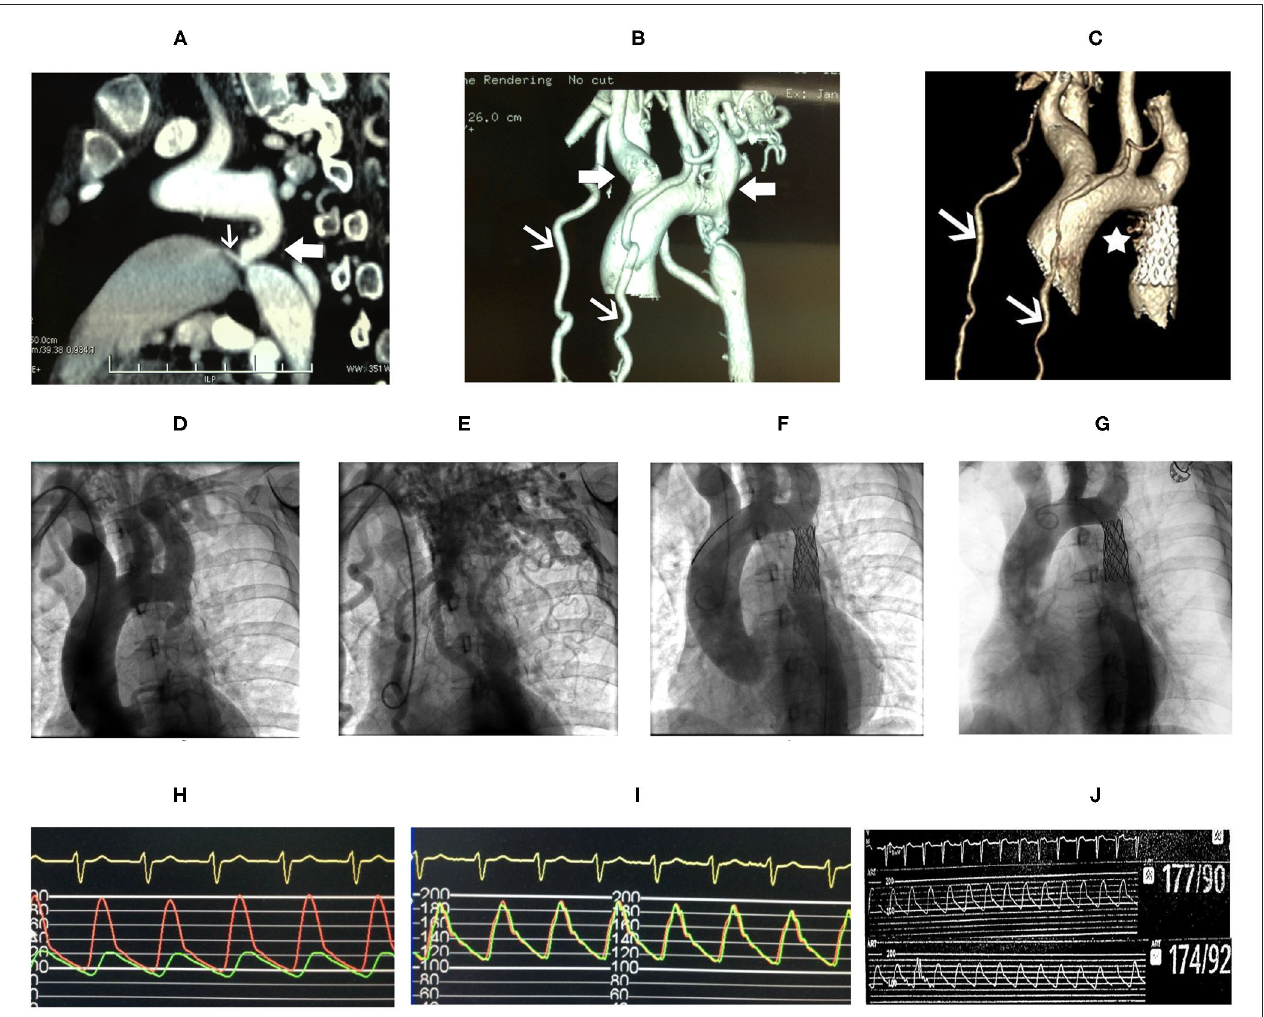
FIGURE 2 | CT angiography (CTA) of the aorta (A) showed marked narrowing in the isthmic region of the descending aorta (white block arrow) and patent ductus arteriosus (PDA) (white arrow) connecting the aorta and the pulmonary artery. Dilatation of the innominate artery and the left subclavian artery (white block arrows) , and extensive collateral circulation (white arrows) were shown in (B) . Follow-up CTA of the aorta 8 years after stent repair showed reduced collateral circulation (C, white arrows) , and the PDA is not shown (C, asterisk) . Aortic angiography showed remarkable isthmic coarctation of the aorta with dilated innominate artery and left subclavian artery (D) and exuberant collateral circulation (E) . Pressure gradient between the proximal and distal ends to the aortic obstruction was 74 mmHg (H) . The descending aorta, after placement of stent, was shown (F) with equalization of pressure at the proximal and distal ends of the descending aorta (I) . Repeated aortic angiography at 8-year follow-up showed patency of the covered stent and reduction in collateral circulation (G) , and no pressure gradient was found, 177/90 mmHg at the proximal vs. 174/92 mmHg at the distal end of descending aorta, respectively (J)